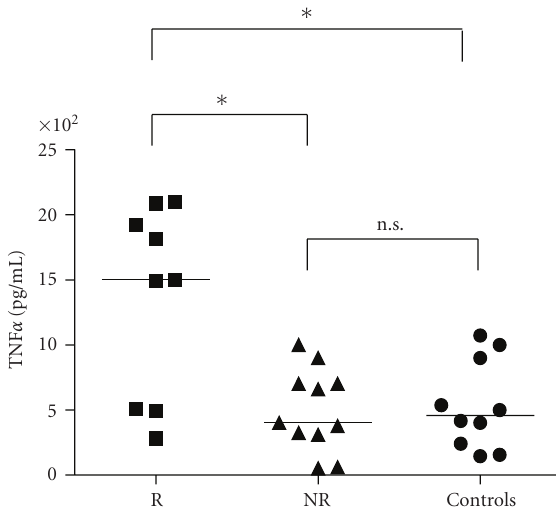
Figure 1: In patients developing left ventricular remodeling after myocardial infarction (R, n = 20) lymphomonocyte production of TNF- α in response to LPS was increased in comparison with patients not developing left ventricular remodeling (NR, n = 20) and in comparison with controls on day 1 after reperfusion ( ∗ P < . 05).